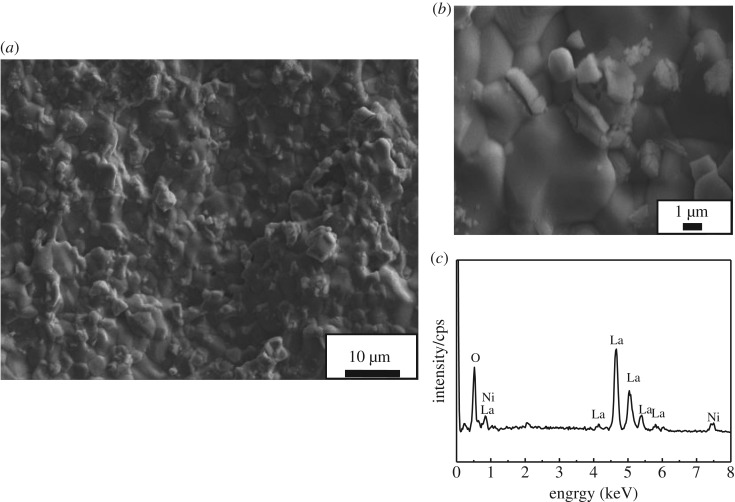
SEM and EDX of La2NiO4 surface heat-treated in the presence of Cr2O3 at 800°C for 24 h. (a) ×1000, (b) ×5000, (c) selected EDX points.